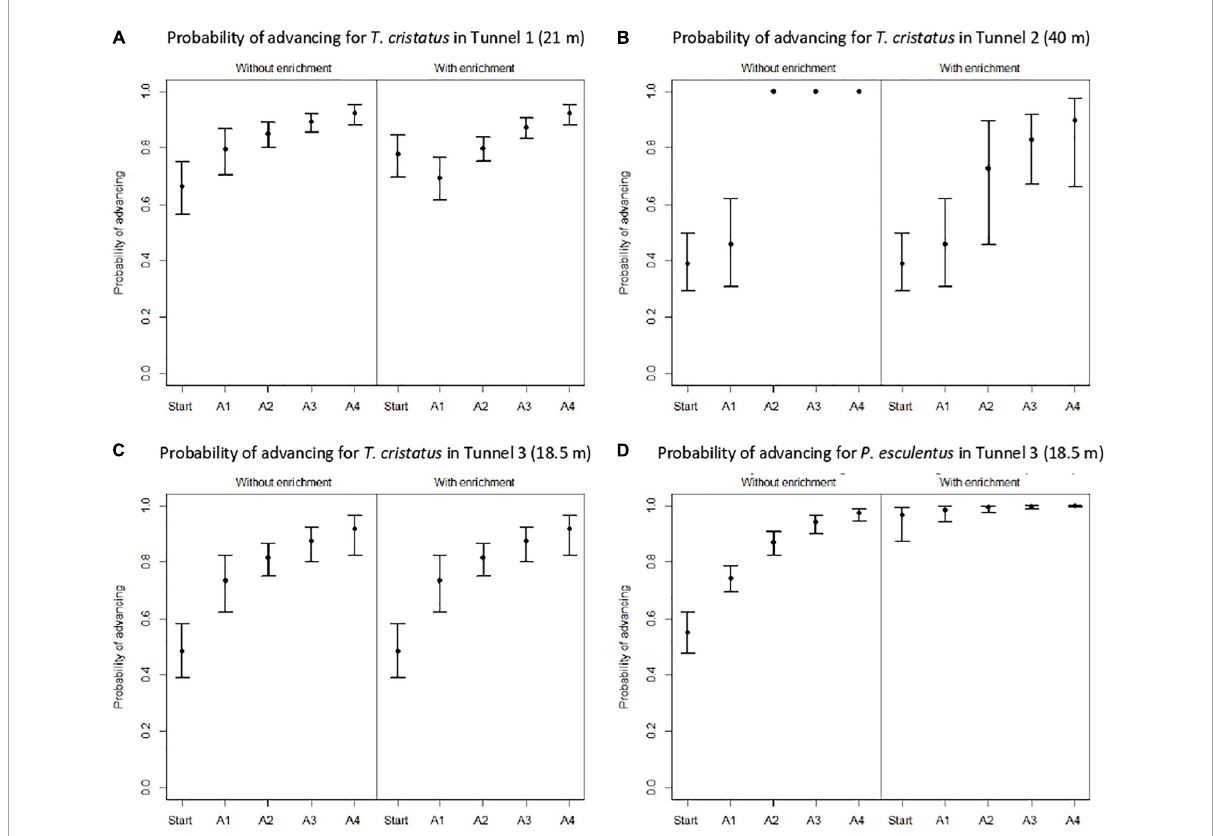
FIGURE5 Probability of going forward (advancing) for the great crested newt in the three tunnels (A–C) , and the water frog in Tunnel 3 (D) . Mean probability and confidence intervals of 95% were estimated with the best model from the selection